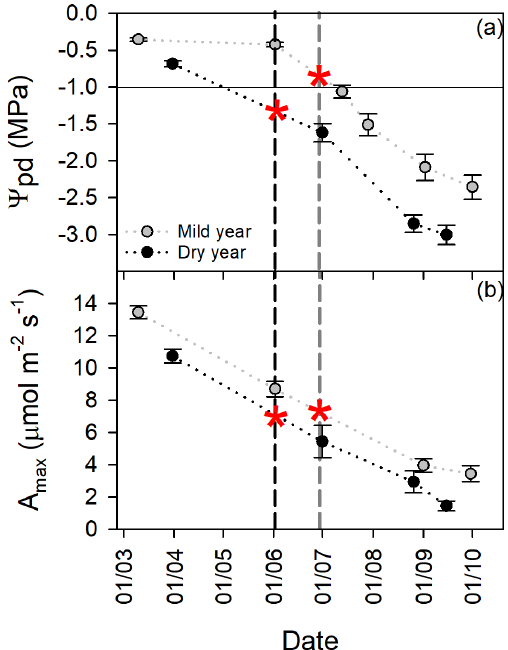
Figure 5. Tree physiological status over the growing season in the mild and in the dry year. (a) Predawn leaf water potential ( (cid:57) pd , MPa). (b) Maximal photosynthetic rate ( A max , µmolm − 2 s − 1 ). Vertical dashed lines represent the mean day of growth cessation for mild (grey) and dry (black) years. Red asterisks are indicative of the interpolated (cid:57) pd and A max at growth cessation. The hori- zontal black line is a reference for the reported threshold of (cid:57) pd ( − 1.0MPa) for growth cessation in cork oak (Pereira et al., 1987). Values are mean ± SEM ( n = 15).